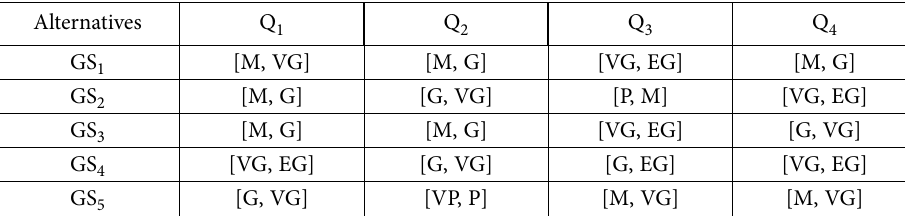
Table 3. The ULTSs through DM